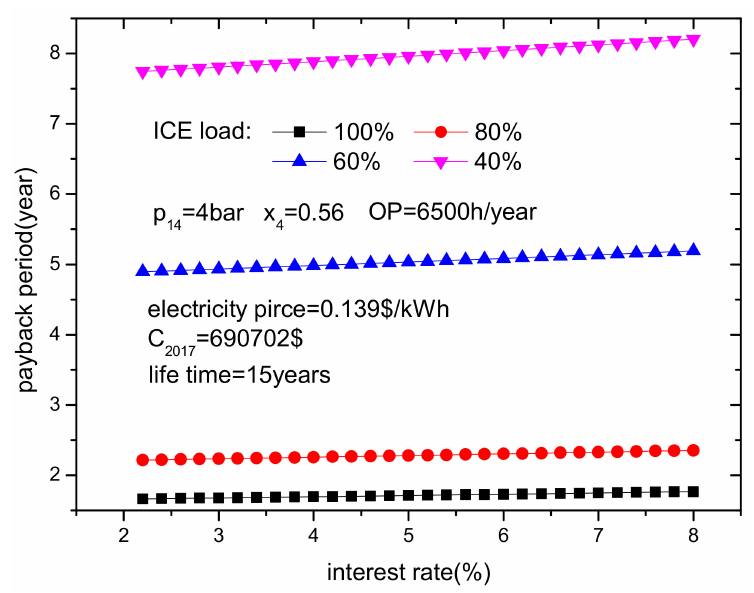
Figure 15. Effects of interest rate on payback